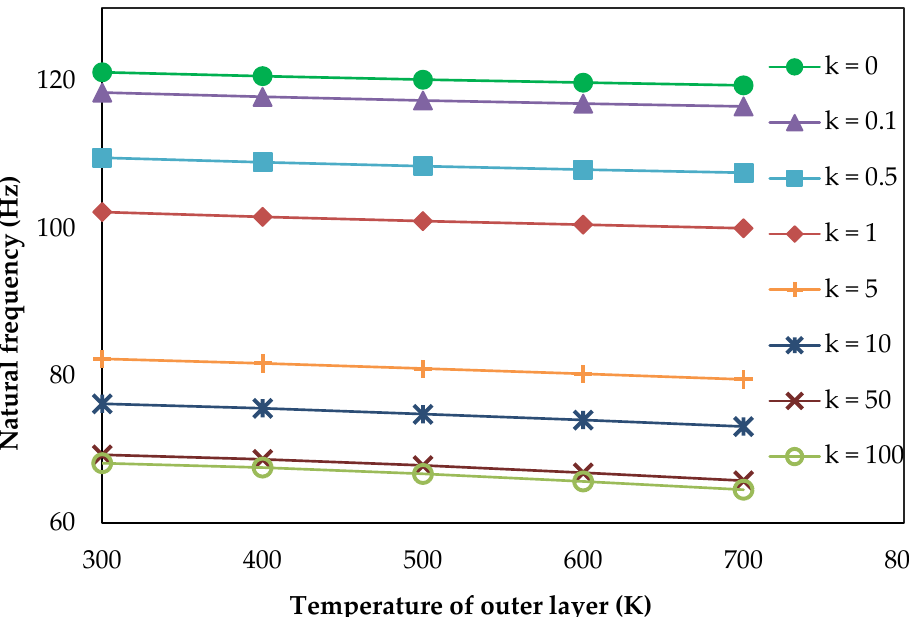
Figure 12. Variation of the natural frequency of an aluminum/aluminum oxide FGM shell under a linear temperature rise for different material composition for re-entry vehicle nose structures.